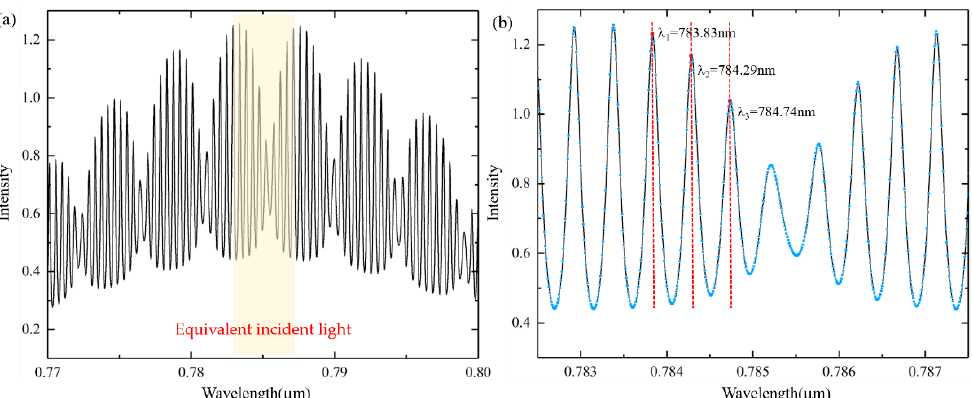
Figure 5. ( a ) The equivalent incident light I total of F-P cavity effect (wavelength resolution ∆ λ = 0.01 nm). ( b ) Detailed information about the wavelength range of 782.5 nm – 787.5 nm with a wavelength resolution of 0.01 nm.